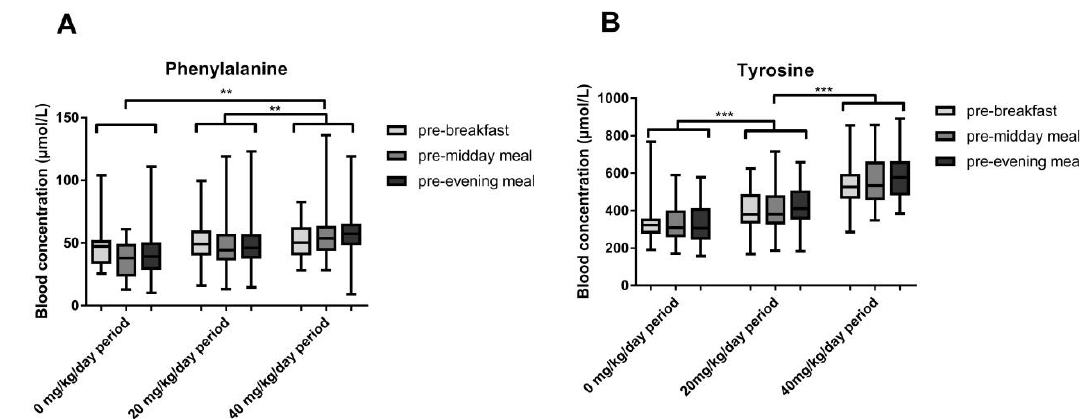
Figure 1. Mean blood phenylalanine ( A ) and tyrosine ( B ) concentrations during the different study